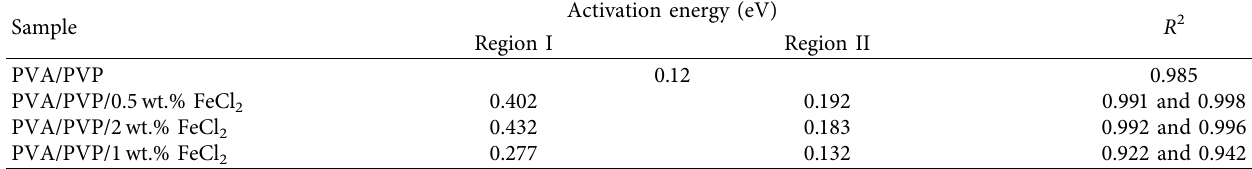
Figure 14: (a) Frequency dependence of AC conductivity at different temperatures and (b) log ( σ ) versus 1000/T, for 2 wt.% FeCl electrolyte blend. Table 2: Values of the activation energy for pure and electrolyte PVA/PVP blend sample. Sample